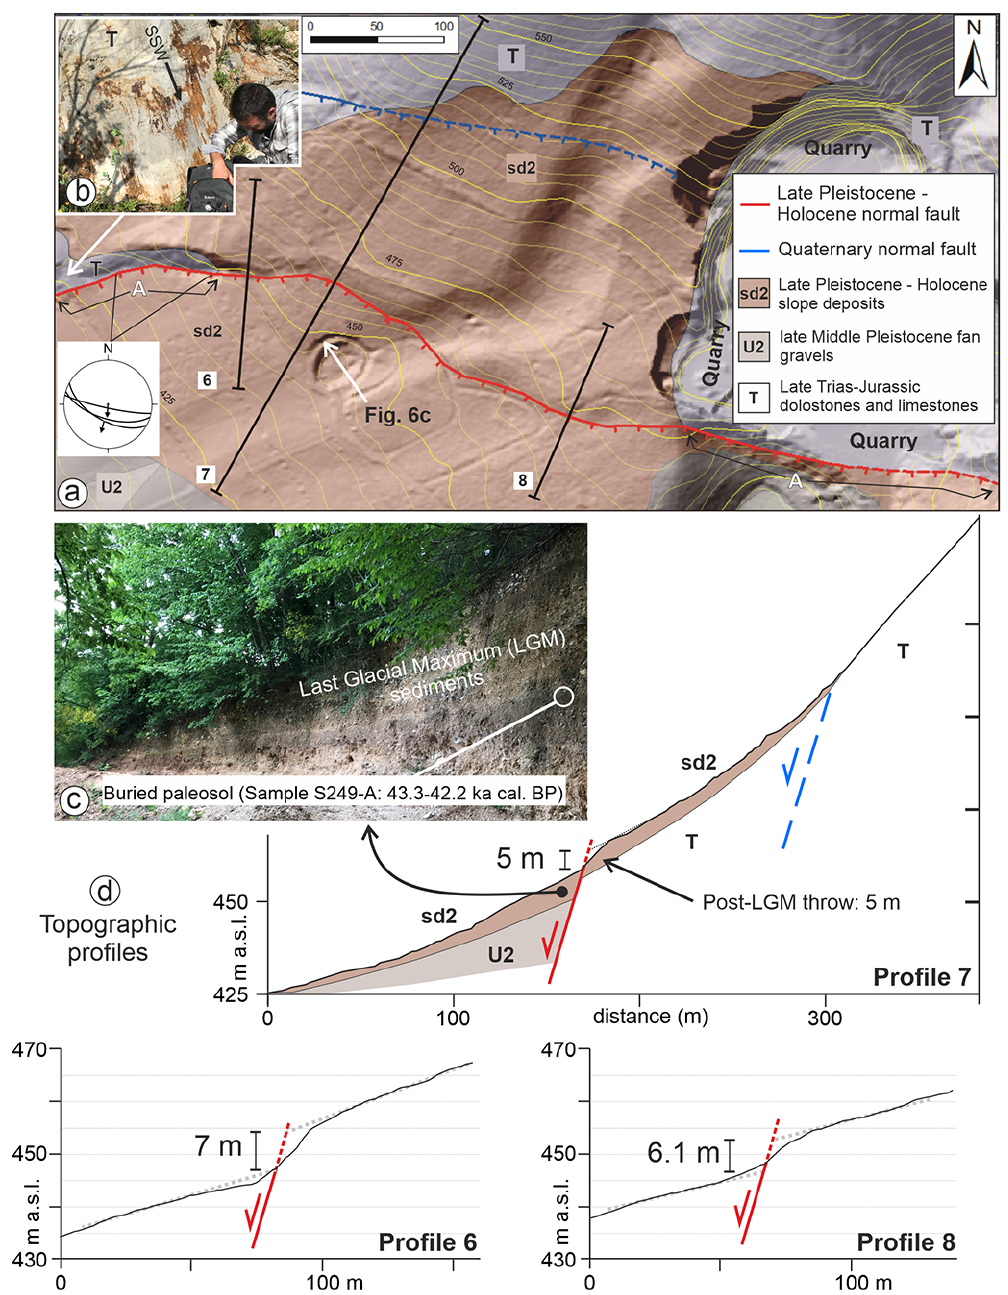
Figure 6. Detail of the geologic map (a) , view of the striated fault plane on bedrock (b) , field view of the sd2 slope sediments within which a buried paleosol was sampled for radiocarbon dating (c) , and topographic profiles across the Gioia Sannitica normal fault trace (San Potito fault section) (d) . The area marked with “A” in (a) is scarp disturbed by anthropic activity (not analysed for scarp measurements). The topography is from the 1m resolution lidar DEM. The location of this area is shown in Figs. 2b and